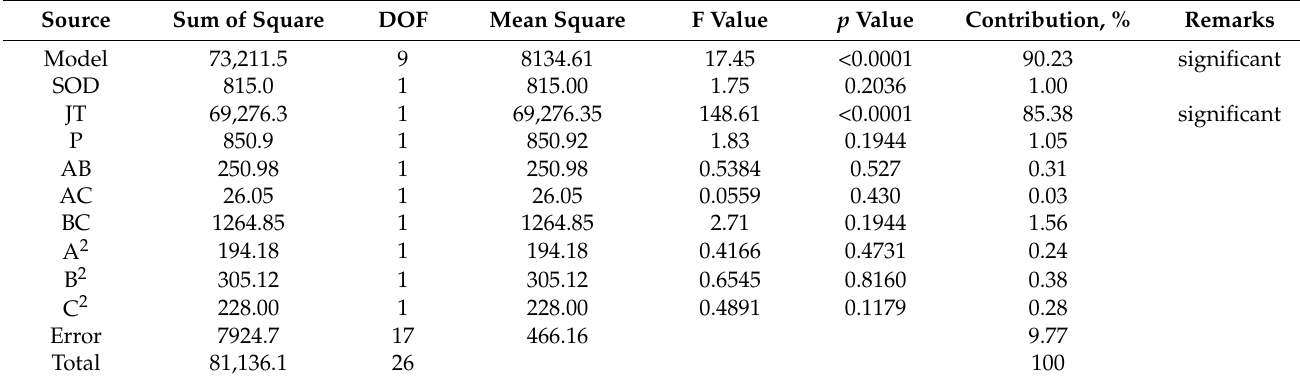
Table 4. The ANOVA for